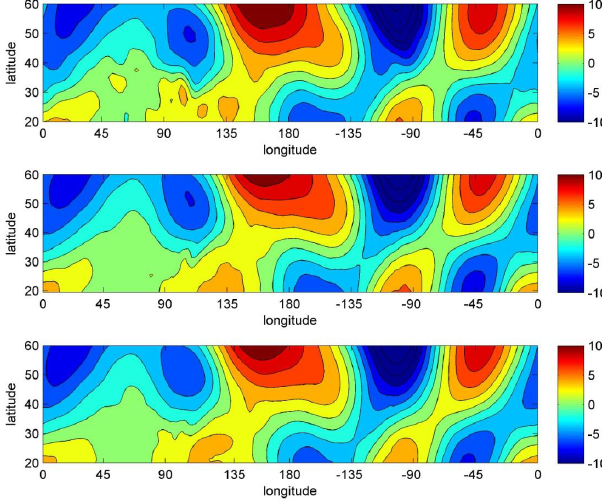
Figure 1. Plot of average meridional wind speed (ms − 1 ) com- ponent for January at 20–60 ◦ N, 180 ◦ E–180 ◦ W and 10hPa. Top panel NCEP/NCAR (1958–2012), middle ERA-Interim (1979– 2012), and bottom MERRA (1979–2012). Positive values (pole- ward wind): red; negative values (equatorward wind): blue.